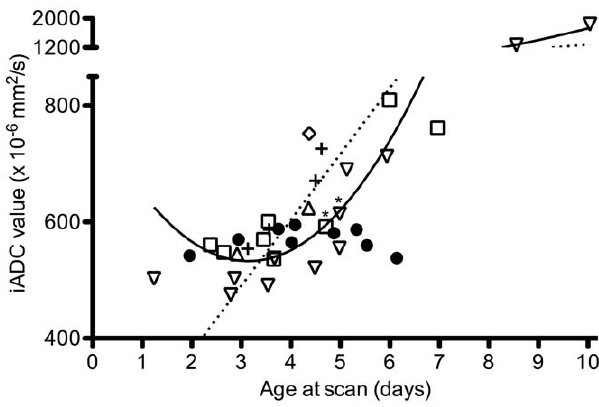
Figure 2. Time course of the ADC values. ADC values were N determined in the core of the stroke in 36 infants with a MCA main ), anterior MCA trunk ( n ), posterior MCA trunk ( , ), trunk ( lenticulostriate branches ( e ), cortical branch ( % ) and PCA ( + ) stroke. The regression lines for the linear (dashed line) and quadratic regression (continuous line) are depicted. Two infants who were scanned following total body cooling are identified with an asterisk (*).